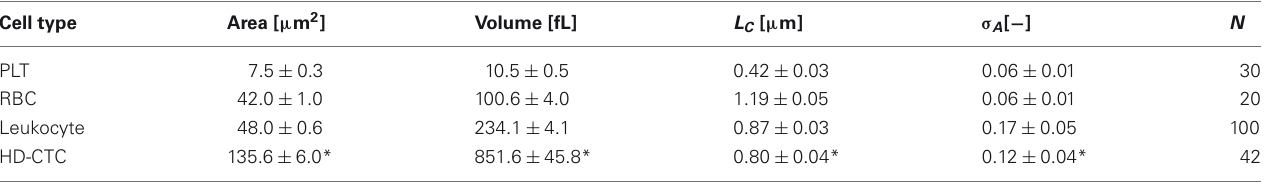
Table 1 | Biophysical properties of normal peripheral blood cells and breast cancer associated HD-CTCs.